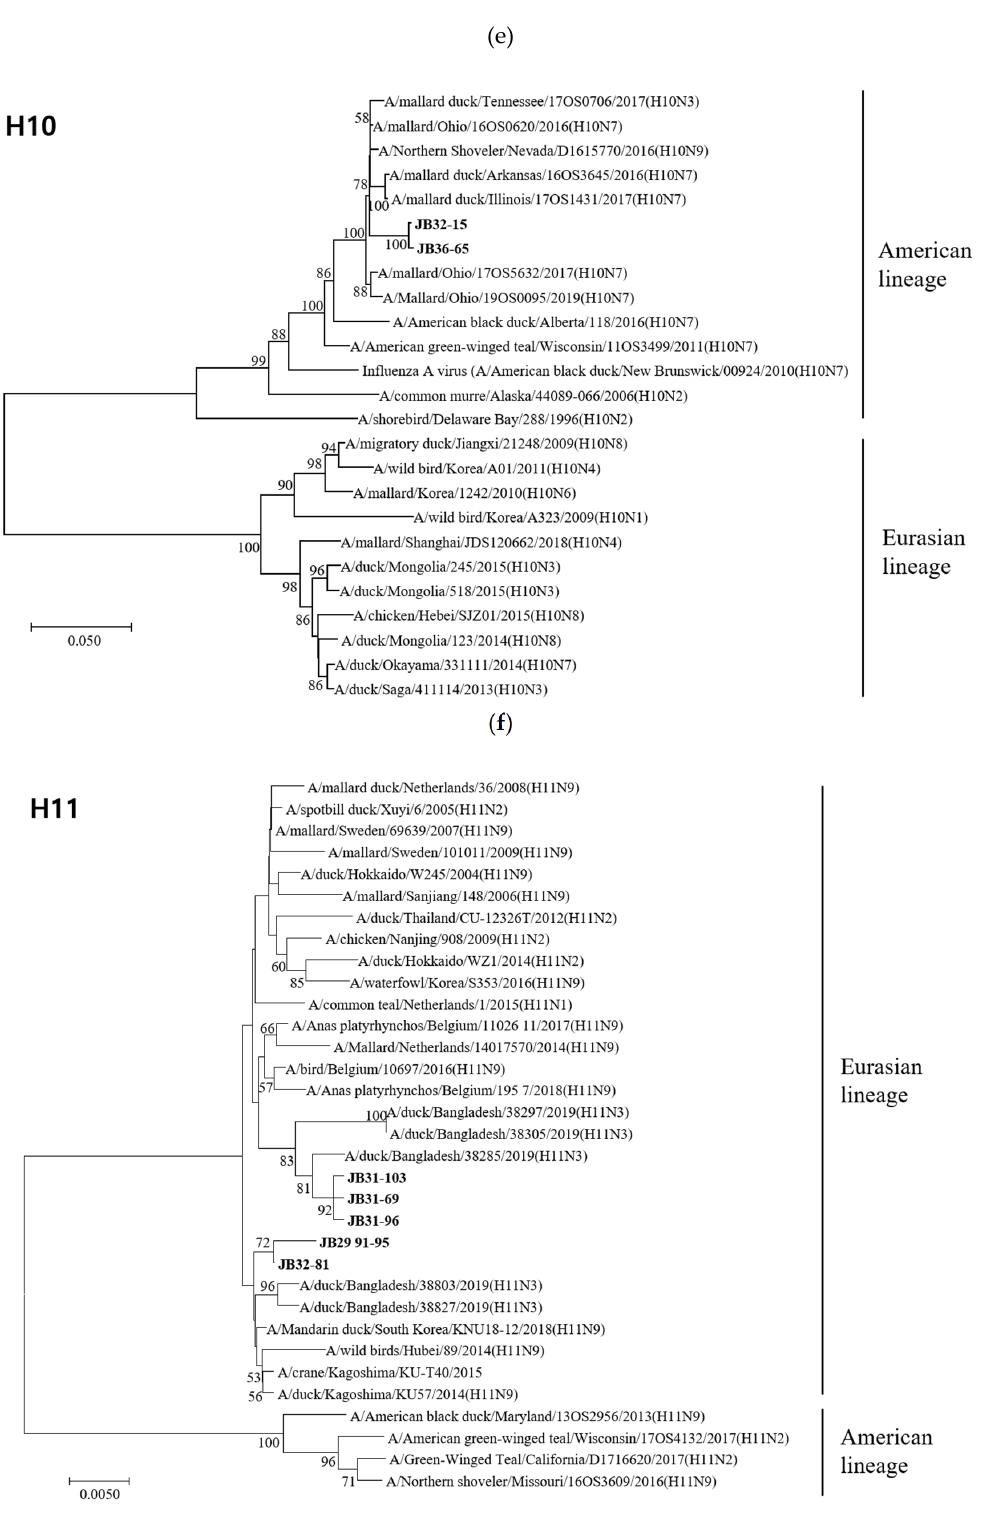
Figure 2. Phylogenetic trees based on the nucleotide sequences of H4 (a), H5 (b), H6 (c), H9 (d), H10 (e) and H11 (f) genes. Trees were produced by the neighbor-joining method and bootstrapped with 1000 replicates. Branch lengths are numbers of nucleotide substitutions per site; only bootstrap values at or above 50% are shown. Isolates identified in this study are shown in